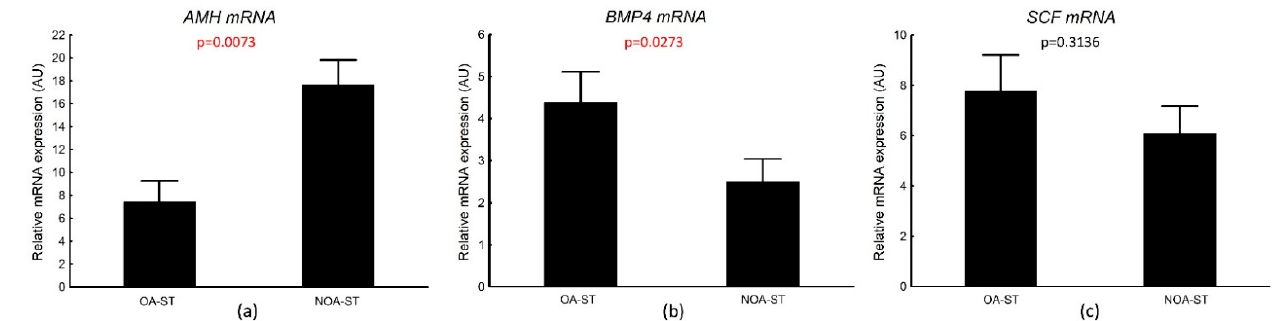
Figure 5. Transcriptional levels of: ( a ) anti-Müllerian hormone ( AMH ); ( b ) bone morphogenic protein 4 ( BMP4 ); ( c ) stem cell factor ( SCF ) in laser-microdissected seminiferous tubules in the analyzed subgroups (OA-ST and NOA-ST). AU—arbitrary units (relative quantification normalized to the reference gene RPS29 using the Δ Ct method). Data are presented as mean± SEM; p value—Mann–